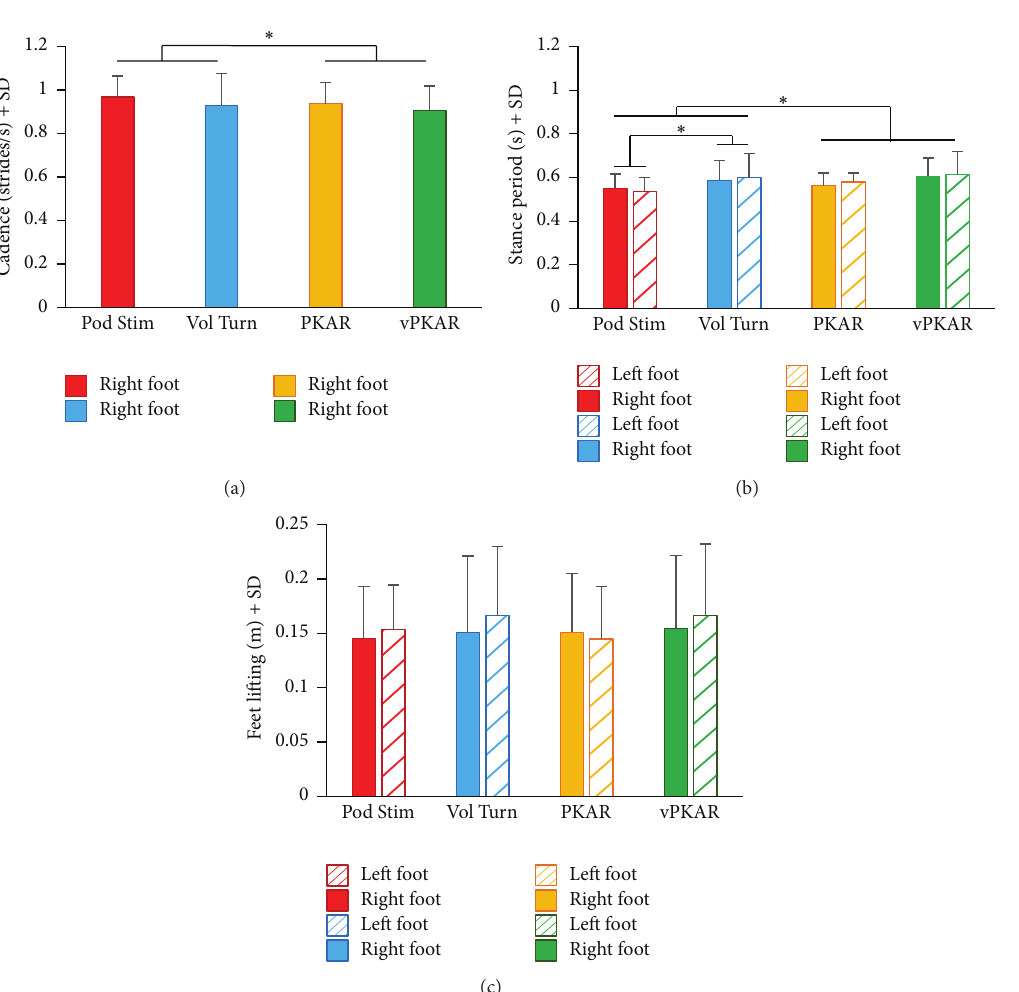
Figure 5: Cadence (a), duration of stance period (b), and height of feet lifting (c) during Pod Stim, Vol Turn, and the two posteffects. Cadence wasnotdifferentbetweenVolTurnandPodStimbutdifferentbetweenpre-andposteffects.Thestanceperiod(b)wassomewhatlongerduring voluntary turning than during Pod Stim. Filled bars refer to the foot corresponding to the direction of rotation (right foot); striped bars refer to the foot opposite to the direction of rotation (left foot). There were no differences in height of feet lifting (c) between Vol Turn and Pod Stim or between the two posteffects. ∗ indicates significant difference ( 𝑝 < 0.05 ) between mean cadences (a) and mean stance period durations